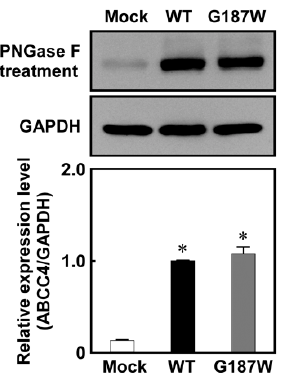
Figure 4. Levels of ABCC4 in cells established using the Flp-In™ system. ABCC4 and GAPDH levels were determined by western blotting analysis with specific antibodies for ABCC4 and GAPDH and their levels were quantified using ImageJ (Wayne Rasband, Bethesda, MD, USA) as described in Materials and Methods. ABCC4-specific monoclonal antibody (M4I-10) or GAPDH-specific antibody was used for protein detection in PNGase F-treated cell lysate. The experiments were performed independently more than two times. Data are expressed as mean values ± S.D. (n = 3). Statistical analyses were performed using one-way ANOVA and Tukey’s HSD test (* p < 0.01 compared to the Mock group).